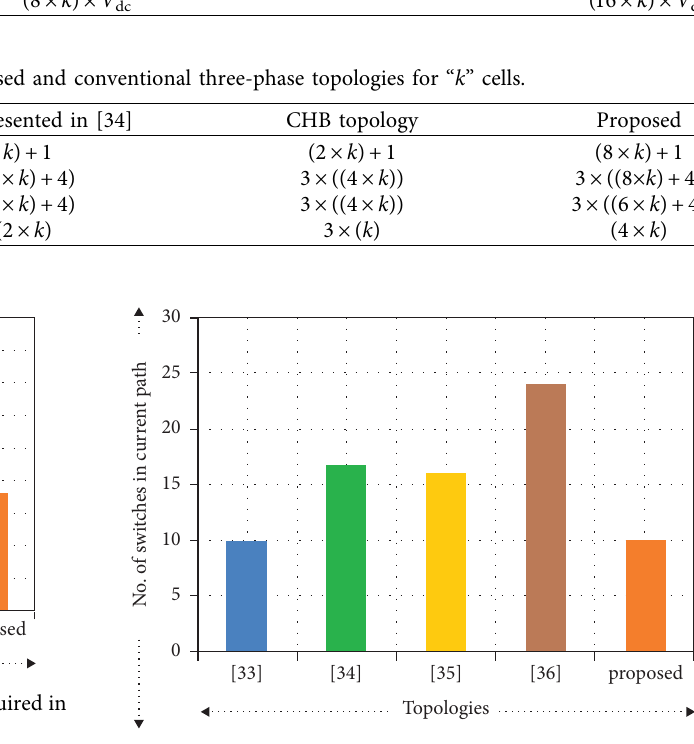
Figure 9: Comparison of number of current conducting devices required in recent topologies vs. proposed